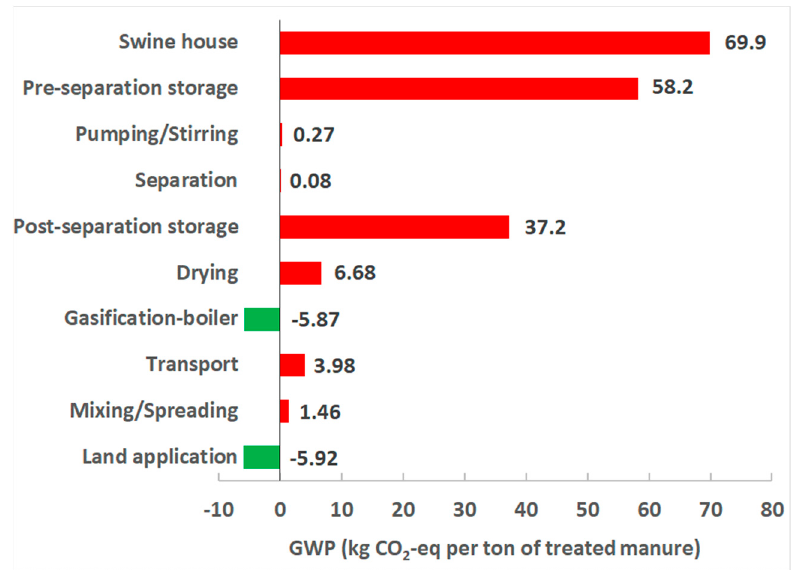
Figure 2. The net contribution of each stage to the cumulative global warming potential over 100 years (GWP 100a) in units of kg CO 2 equivalent (kg CO 2 -eq). We used modified Intergovernmental Panel on Climate Change (IPCC, V1.02) [18] GWP factors embedded in the IMPACT World+ method [16].